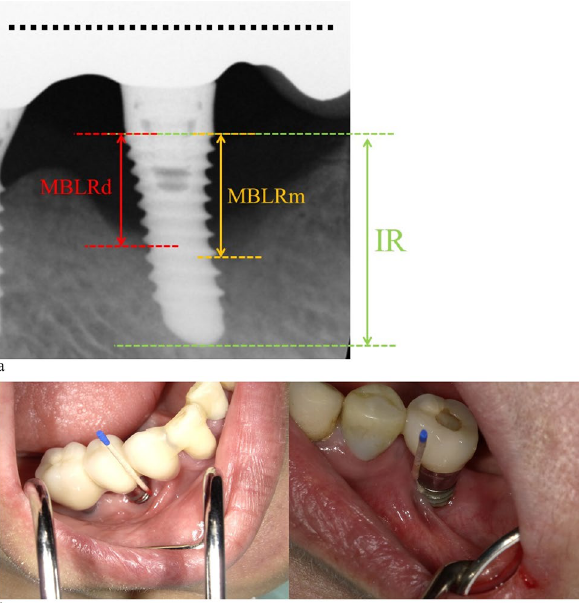
Figure 1. ( a ) Samples were taken from the same oral cavity for both the active and remission peri-implantitis. The extent of bone resorption was calculated by measuring the distance from the implant shoulder (for tissue level, the boundary between the roughened and polished surface) to the most coronal portion of bone-to- implant contact. Implant length of radiograph (IL) is distance from implant shoulder to the most apical site. Marginal bone loss around the implant of radiograph (MBLR) is average distance from the implant shoulder to the most coronal position of bone-to-implant contact in the mesial (MBLRm) and distal (MBLRd) aspects of the implant. The measurement values of marginal bone loss around the implant (MBL) were calculated using the actual implant length (I) and the following ratio: I/MBL = IR/MBLR Peri-implantitis cases with suppuration and bleeding were assigned to the active group, while those without suppuration and bleeding were assigned to the remission group. ( b )The implant with suppuration is